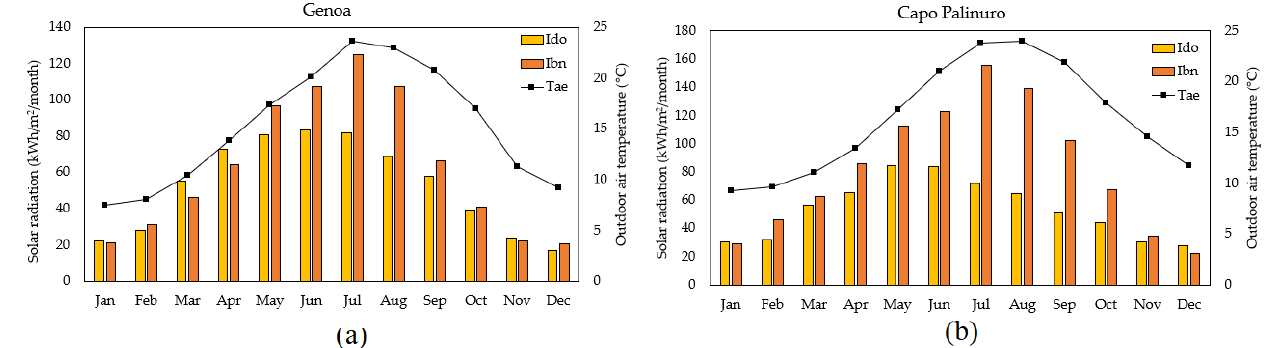
Figure 11. Monthly average climate data (diffuse irradiance on horizontal plane, direct normal irradiance and outdoor air temperature): ( a ) Genoa; ( b ) Capo Palinuro.